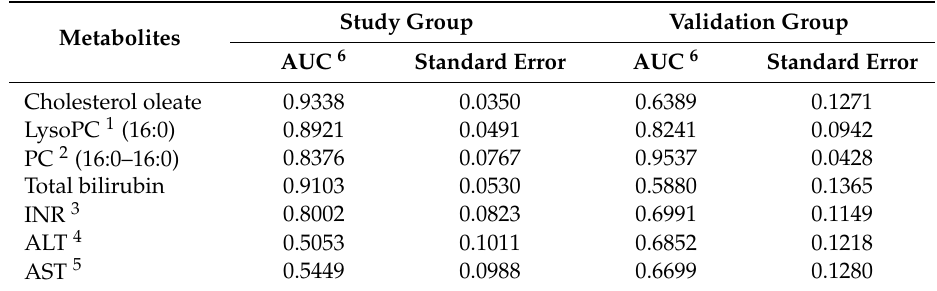
Table 5. Receiver operating characteristic (ROC) curve analysis for individual metabolites in study and validation